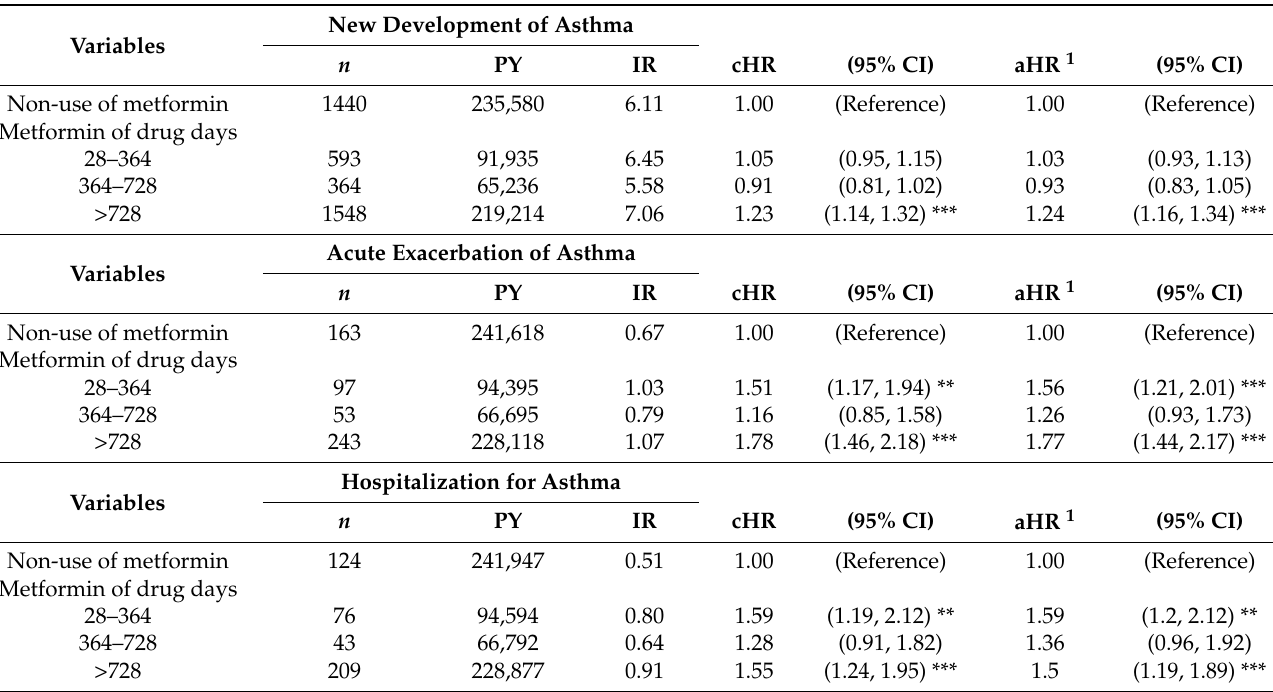
Table 4. Hazard ratios of outcomes associated with metformin